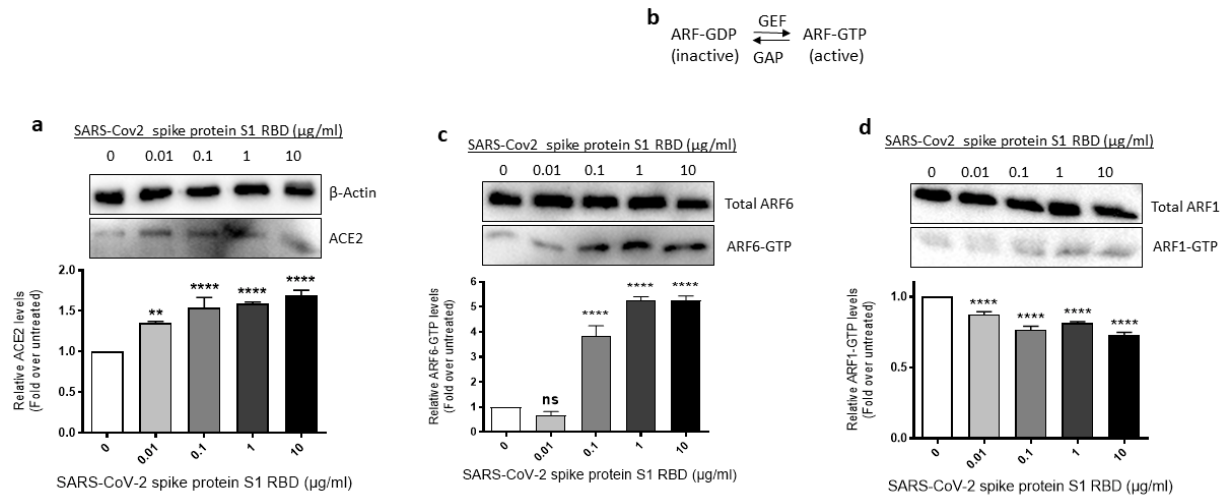
Figure 4. Effect of the SARS-CoV-2 spike protein S1 RBD treatment of EA.hy 296 Cells on ACE2 expression and ARF6 activation. EA.hy 296 cells were treated with 0–10 µg/mL RBD manner for 72 h and lysed. ( a ) The cell lysates were analyzed for ACE2 protein expression by immunoblotting using the ACE2 inhibitory antibody or β -actin antibody. ( lower panel ) The intensity of the bands in ( a ) was quantified and normalized to the expression of loading control ( β -actin). ( b ) Schematic of the inactivation and activation cycle of ARF and its regulation by GEFs and GAPs. The cell lysates were subjected to GST-GGA3 PBD pulldown to quantify ARF6-GTP ( c ) or ARF1-GTP ( d ). ARF6-GTP or ARF1-GTP levels in the pulldown and total ARF6 or ARF1 levels were assessed by immunoblotting using the ARF6 or ARF1 antibody. The intensity of the bands in the ARF6-GTP ( c , lower panel ) or ARF1-GTP ( d , lower panel ) blot was quantified and normalized to the expression of total ARF6 or ARF1 present in the corresponding sample. Statistical significance was measured by one-way ANOVA comparing the treated with the untreated control (** p < 0.01, **** p < 0.0001. ns, not